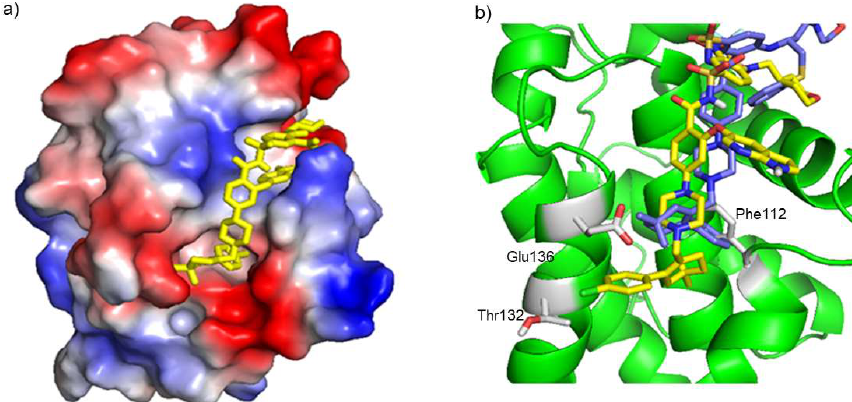
Figure 3. ( a ) Representation of venetoclax binding mode toward chimeric Bcl-2 predicted by AutoDock. Bcl-2 electrostatic surface potential is represented, where negative charges are shown in red and positive charges in blue. Venetoclax is represented by sticks in yellow. ( b ) Representation of the interacting residues network between chimeric Bcl-2 (cartoon in green) and venetoclax (sticks in yellow), where the residues Phe112, Thr132 and Glu136 (in red) are specific, when compared to navitoclax binding (sticks in blue). Representation was performed using the PyMOL software (PyMOL Molecular Graphics System, Version 1.8 Schrödinger, LLC).